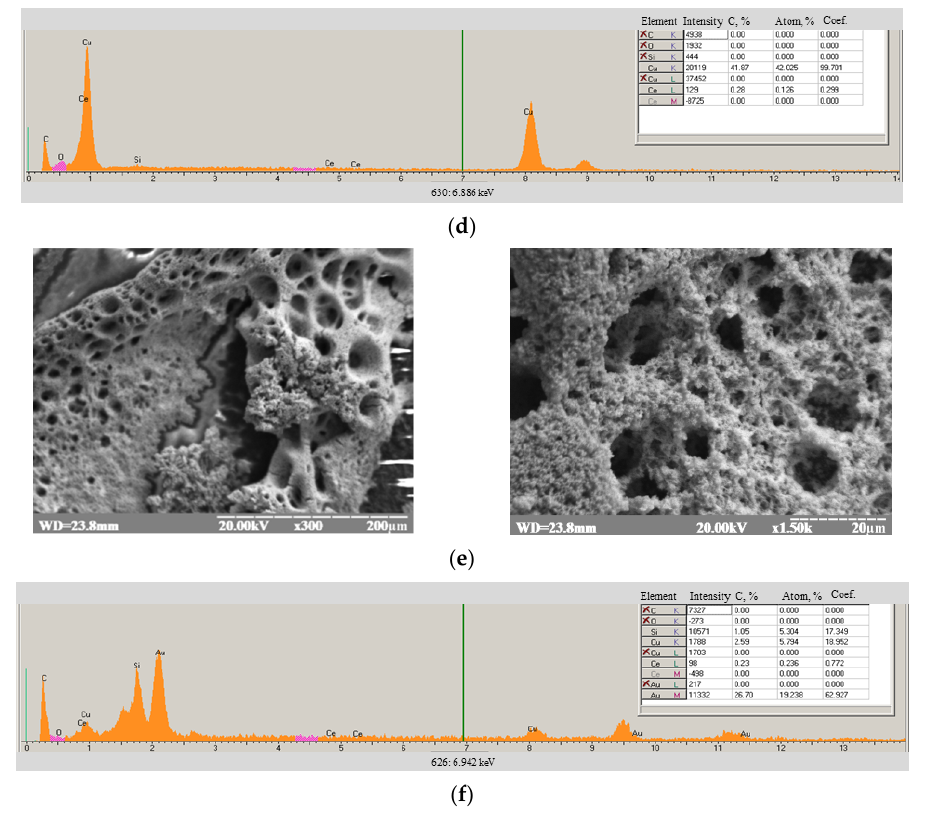
Figure 2. Characteristics of the pAu/GE ( a , b ), nCuCe/GE ( c , d ), and nCuCe/pAu/GE ( e , f ). SEM images with different magnitudes ( a,c,e ); X-ray spectral microanalysis ( b , d , f